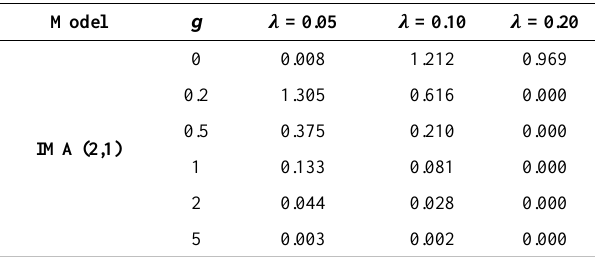
Table 5. Compare the RMI of two models at various